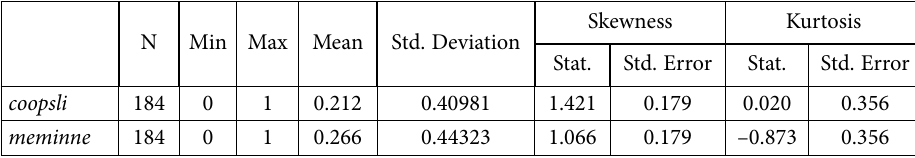
Table 2. Spearman’s rho correlation – H1 (source: authors’ compilation) Spearman’s rho coopsli meminne Note : **Correlation is significant at the 0.01 level (2-tailed).